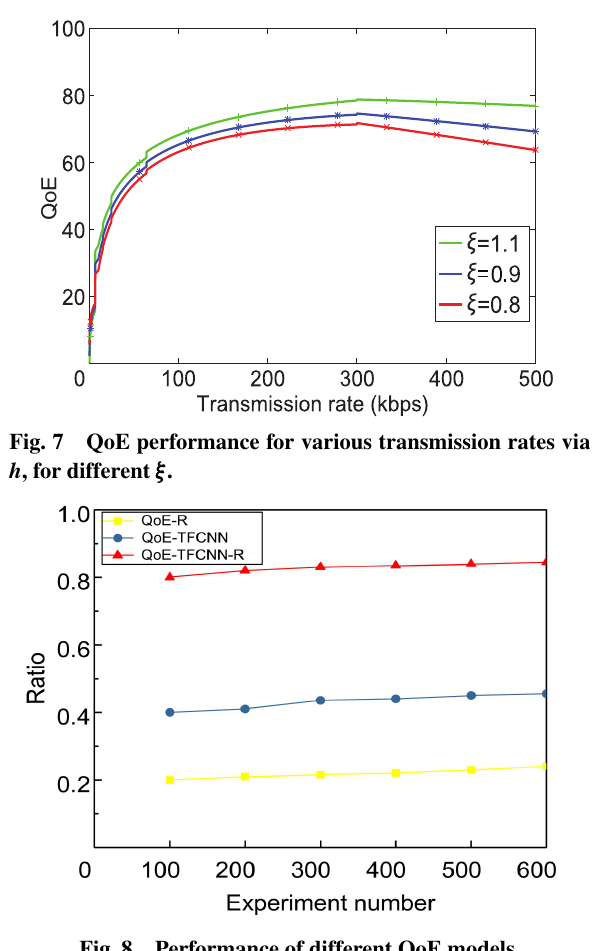
Fig. 8 Performance of different QoE models.